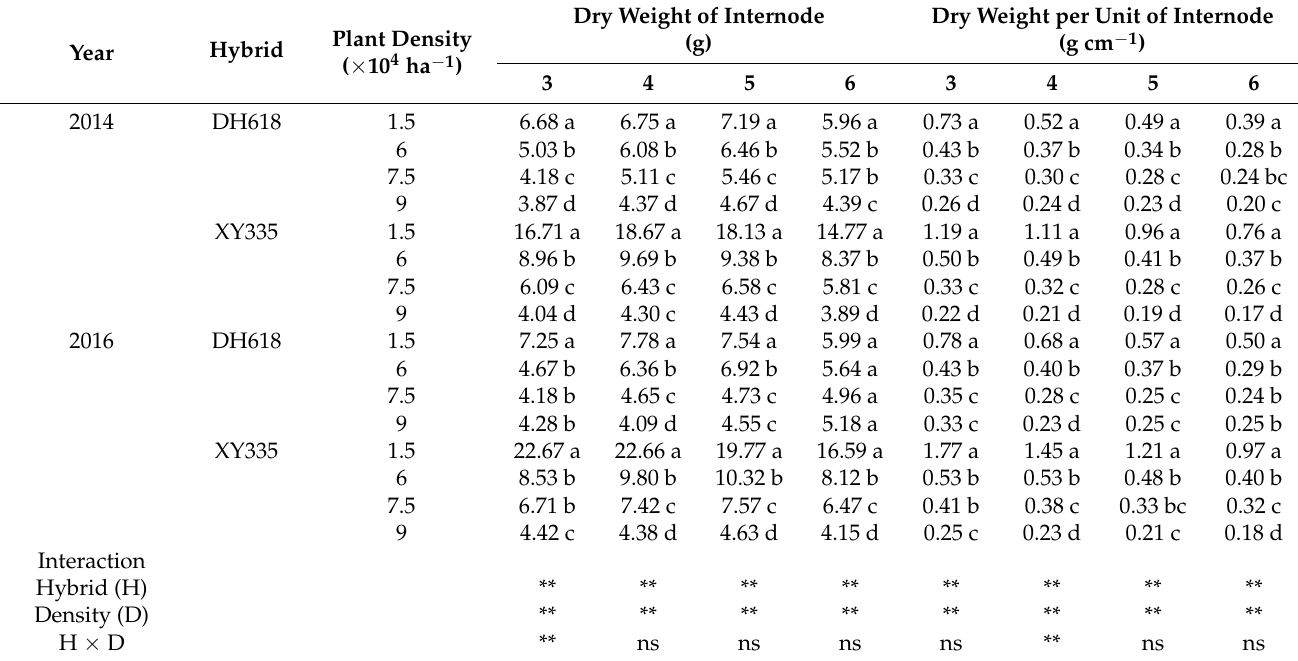
Table 6. Change of the internode dry matter accumulation under different planting densities in 2014 and 2016.